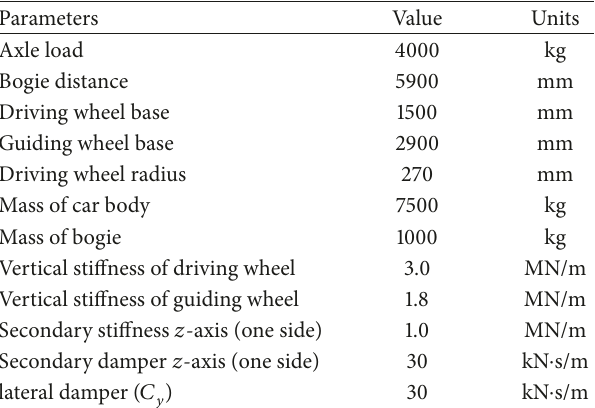
Table 2: Main parameters of the vehicle.